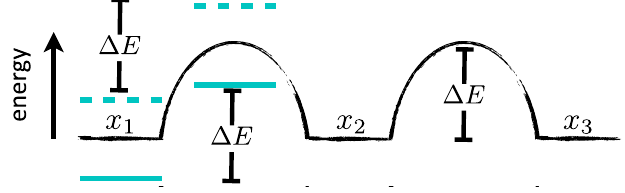
FIG. 1. Three separate microstates initially of equal energy E ¼ 0 are arranged on a line so that stochastic transitions may take place between adjacent locations separated by activation barriers of height Δ E . When state x 1 and the barrier separating it from x 2 are driven, such that their energies oscillate in time, a preference for x 1 over x 3 as a destination for finite time evolution from x 2 develops. This statistical drift is necessarily accompanied by the conversion of absorbed work into dissipated heat in the surroundings. The energies of the driven states are drawn at their extremal values in blue, with dashed lines and solid lines, respectively, in phase with each